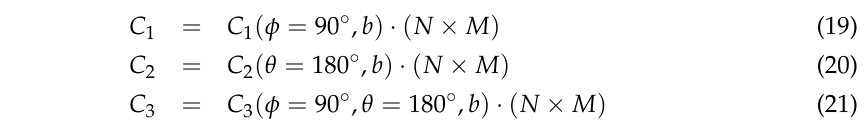
where N and M , respectively, are the width and height of a frame in terms of pixels. Table 3 shows examples of the total capacity per frame that is provided by popular 360 ◦ video resolutions. Depending on the number of bit planes used for viewing direction based data hiding and the selected resolution, total capacity ranges from 1.74 to 172.04 Mbits per frame. As data hiding degrades the visual quality of the 360 ◦ video frames, the wide range of total capacities allows for trading off capacity versus quality such that sufficient data can be hidden per frame while keeping visual quality at a satisfactory